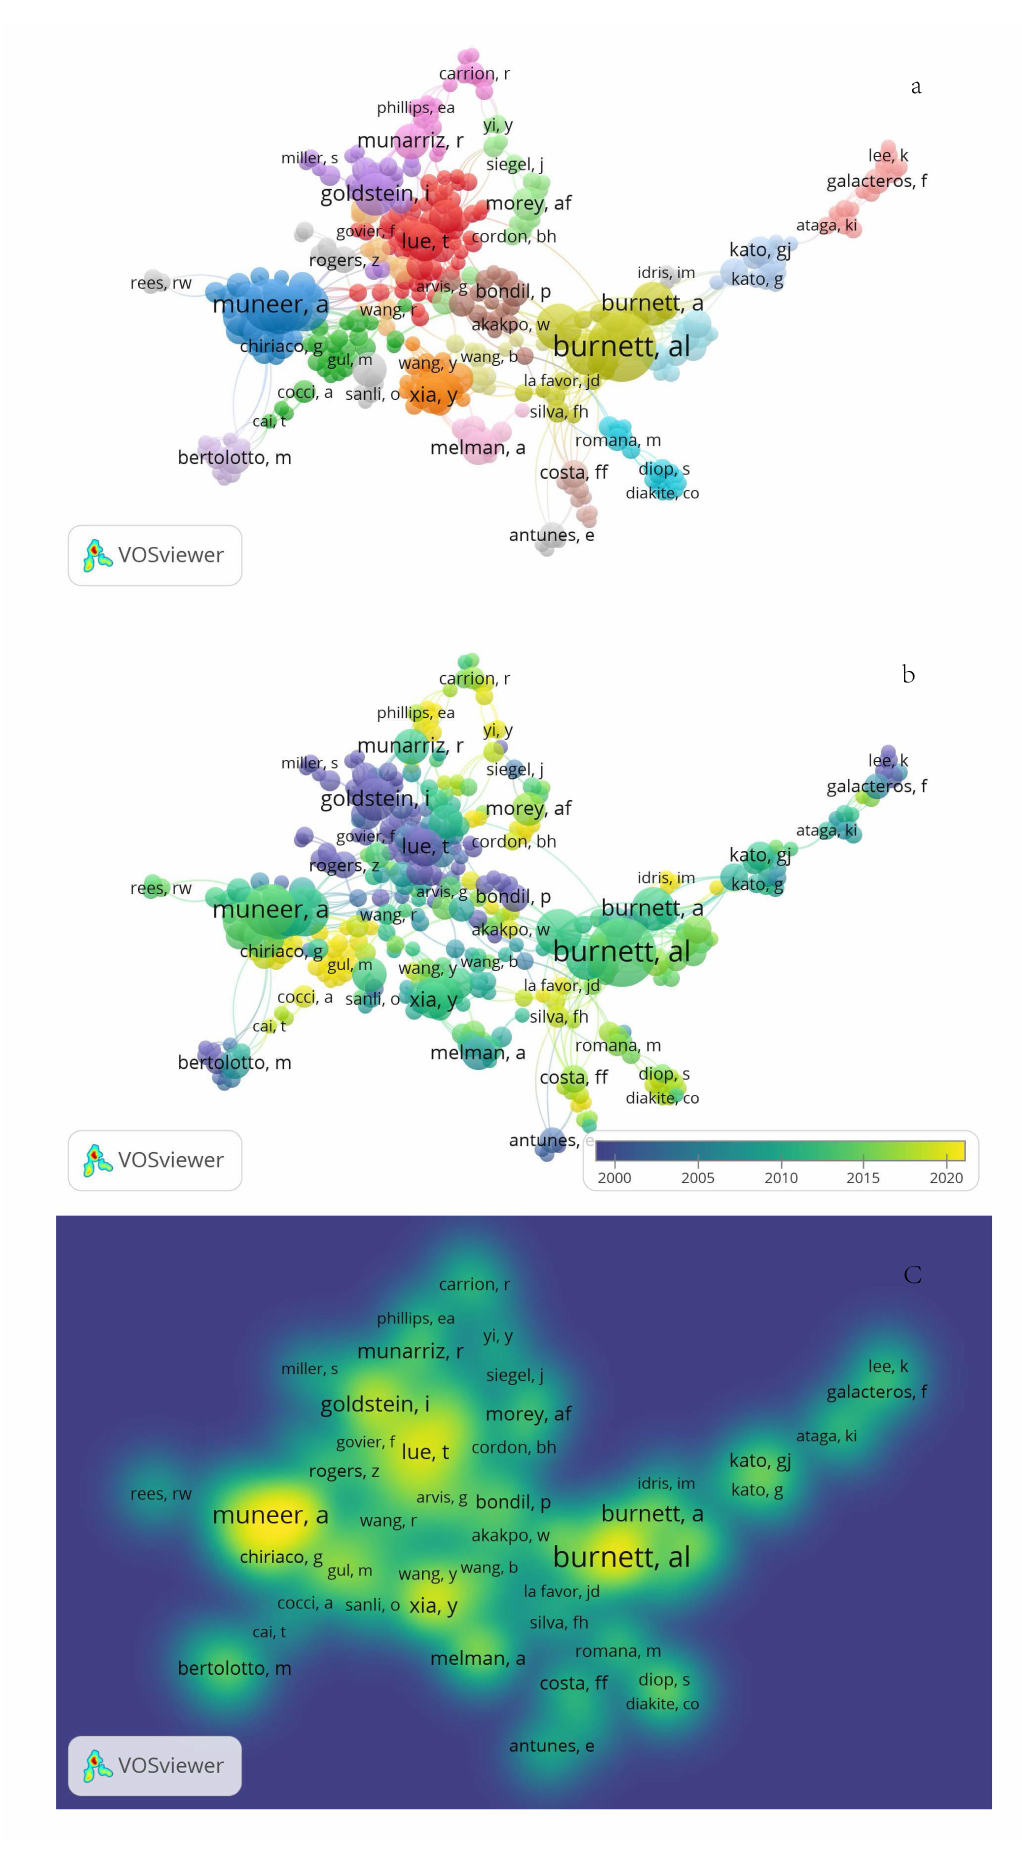
FIGURE 4. The font size of each author represents the number of publications. The thickness of the lines indicates the strength of the connection. a, the authors collaboration network of research on priapism. b, different colors inside the circle represent different time intervals. c, the brighter the color, the more publications for